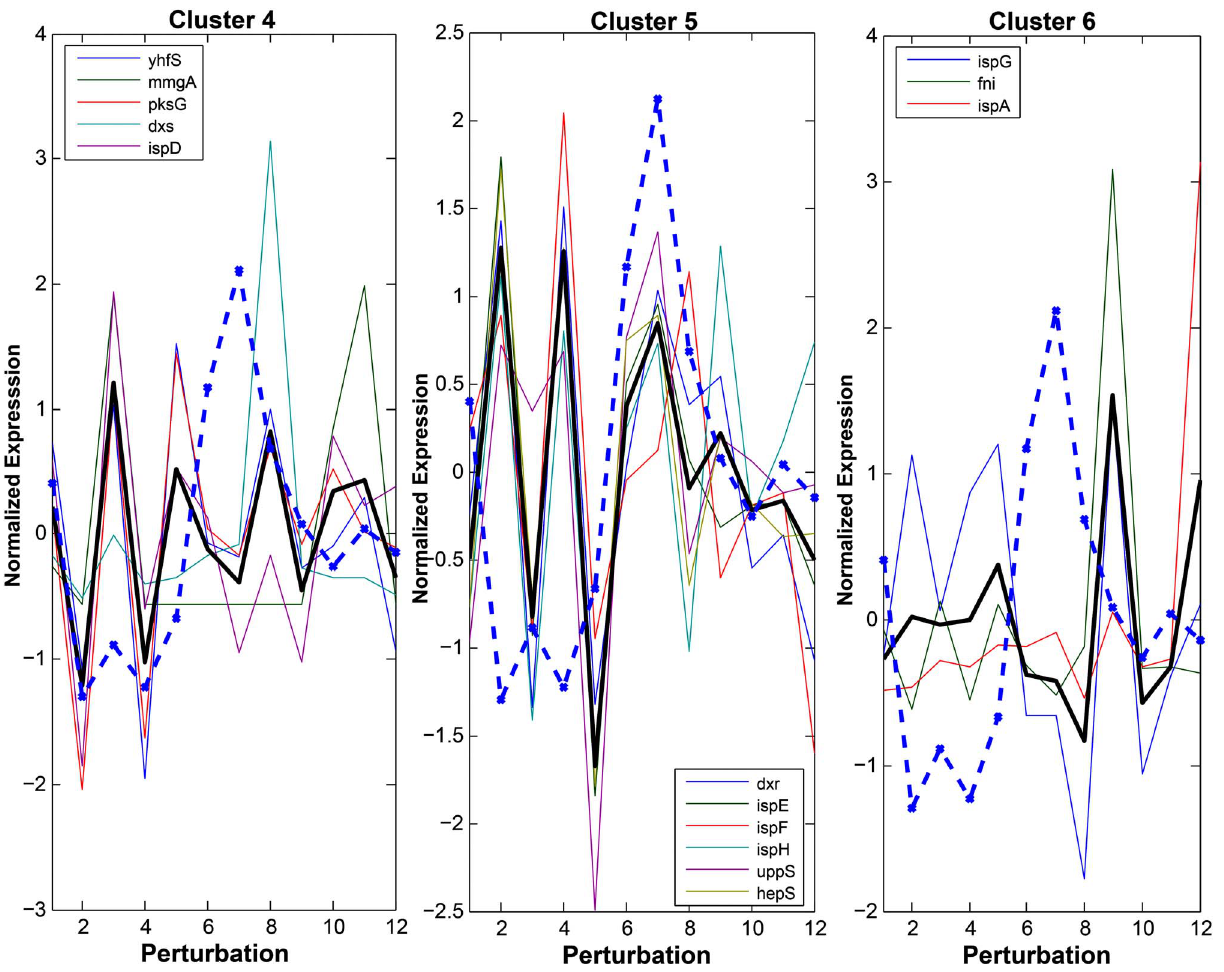
Figure 4. The terpenoid genes cluster into their main groups with respect to coexpression and isoprene production; covariance is dependent upon the type of perturbation. Genes were clustered using k-means. The normalized isoprene production level is represented by the dashed blue line and the mean expression for each cluster is represented by the solid black line in each cluster. The legend in each of the three panels indicates the name of the genes in each cluster. The mRNA levels are normalized (z-score) for each gene. The x-axis is representative of the perturbations as follows (1 through 12): wild type control, acetic acid, ethanol, lactic acid, indole, 0.005% H 2 O 2 , 0.02% H 2 O 2 , OX- dxs , OX- fni , DMSO, empty vector, and OX- ispA